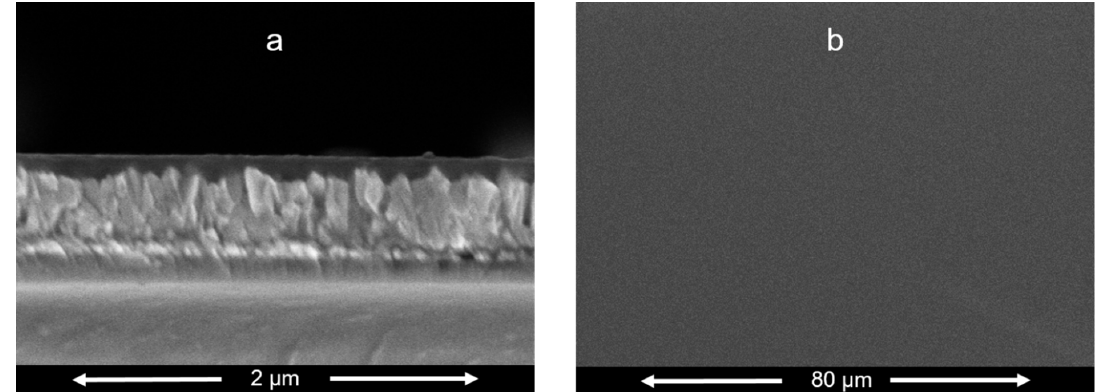
Figure 6. SEM images of the bTAThDaz thin film of FTO substrate. The chart ( a ) shows a cross-section view of the cut. The chart ( b ) shows a top view of the same film.